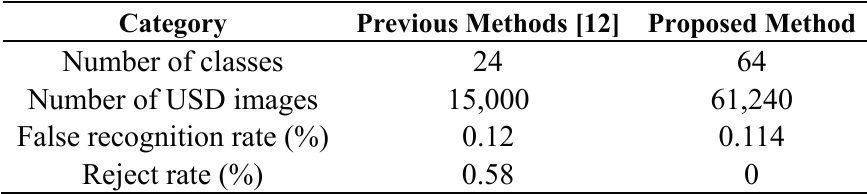
Table 7. Comparison of the accuracy of the proposed method with previous